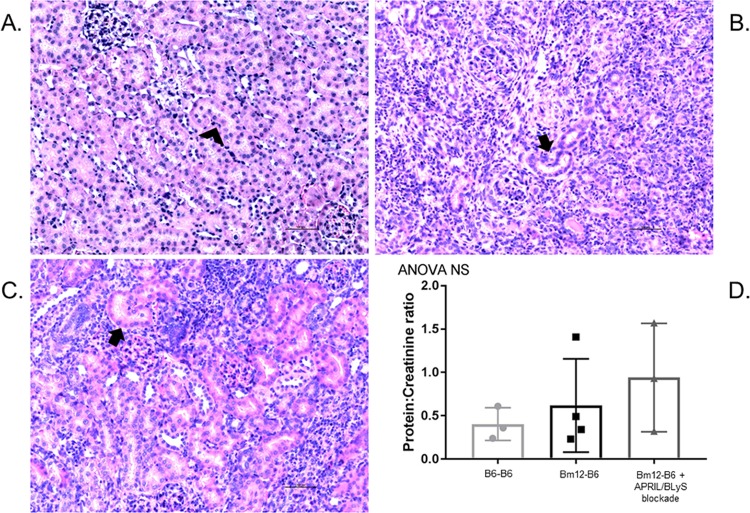
APRIL/BLyS blockade did not prevent rejection in kidney transplant model.Animals underwent kidney transplant and were randomized to receive no treatment or APRIL/BLyS blockade for 1 month post-transplant. (A) B6-B6 kidney transplant did not develop any evidence of rejection. Arrowhead indicates normal kidney tubule. (B) Bm12-B6 developed rejection in 100% of animals and 16.7% (N = 1) developed AMR. Arrow indicates damaged tubule. (C) Bm12-B6 animals treated with APRIL/BLyS blockade also overwhelmingly developed ACR. Arrow indicates damaged tubule. (D) Urine protein and creatinine (UPC) was measured to assess kidney function. UPC ratio was scored as none (UPC <0.5), mild (0.5–1.0), moderate (UPC 1.0–2.0), and severe (UPC >2.0) proteinuria. Proteinuria was not improved in animals who received APRIL/BLyS blockade.